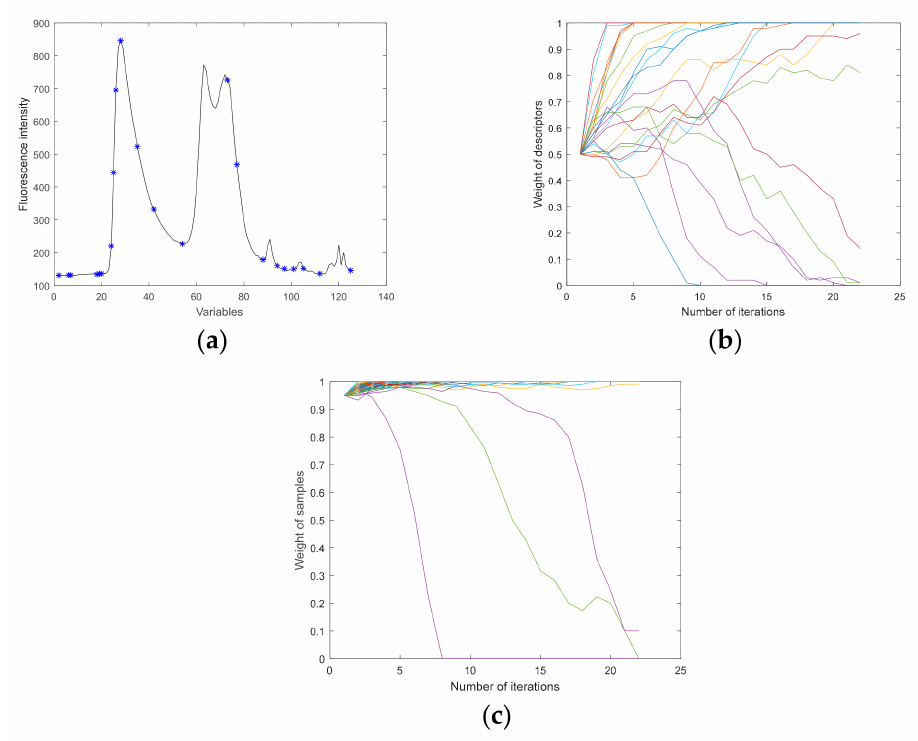
Figure 12. The extraction process of IRIV-MASS: ( a ) distribution of effective variables; ( b ) the change process of the weights of variables; ( c ) the change process of the weights of